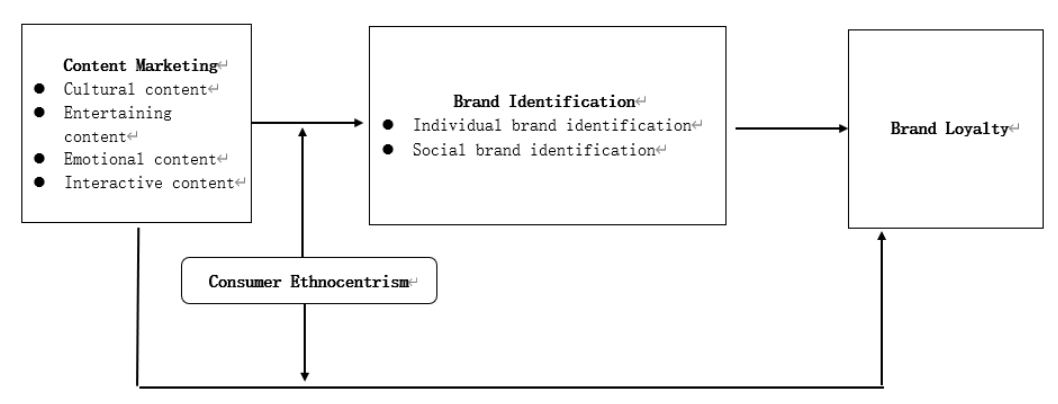
Figure 1: Empirical model on the relationship between content marketing and brand loyalty for “New China Chic”